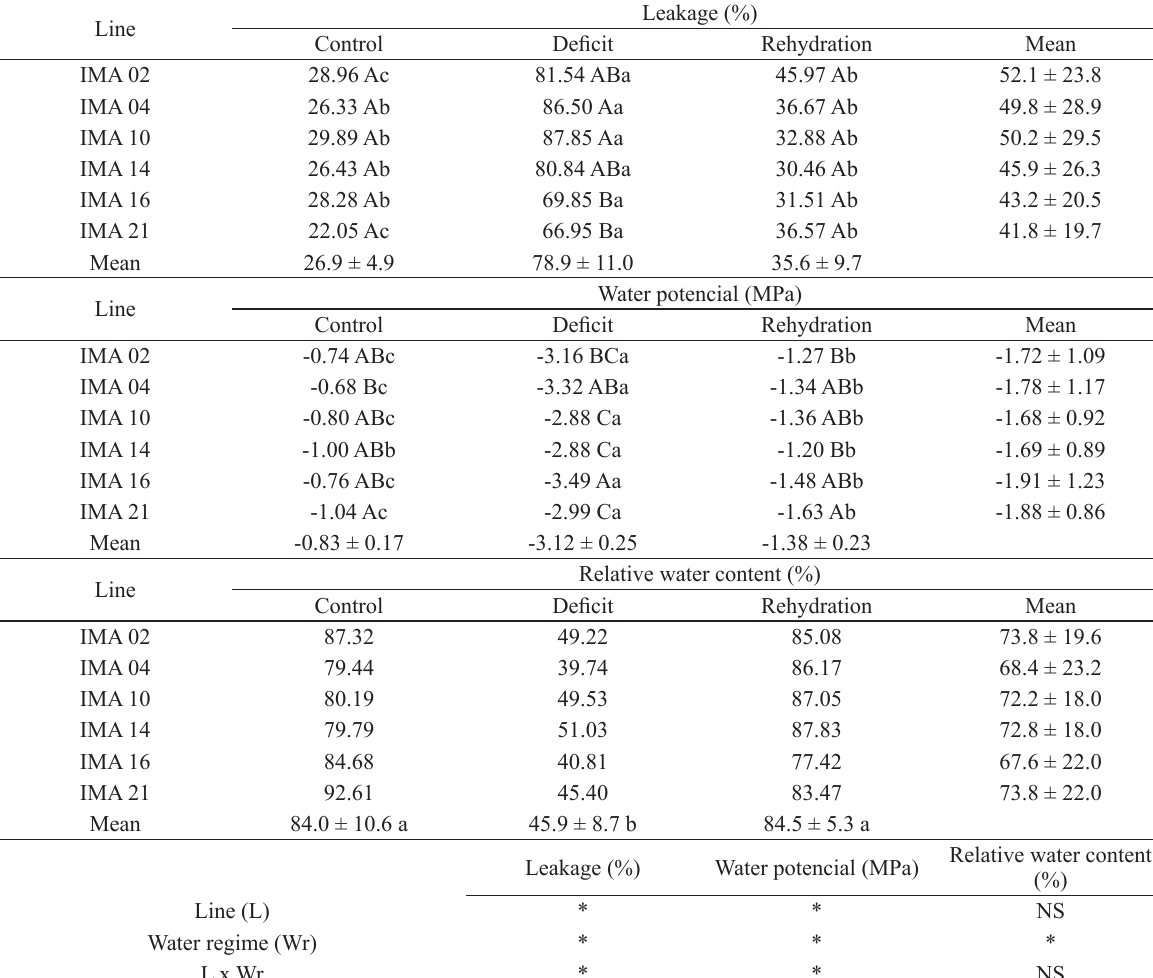
Effect of water deficit and rehydration on electrolyte leakage, leaf water potential and relative water content of six safflower lines in Botucatu – São Paulo,